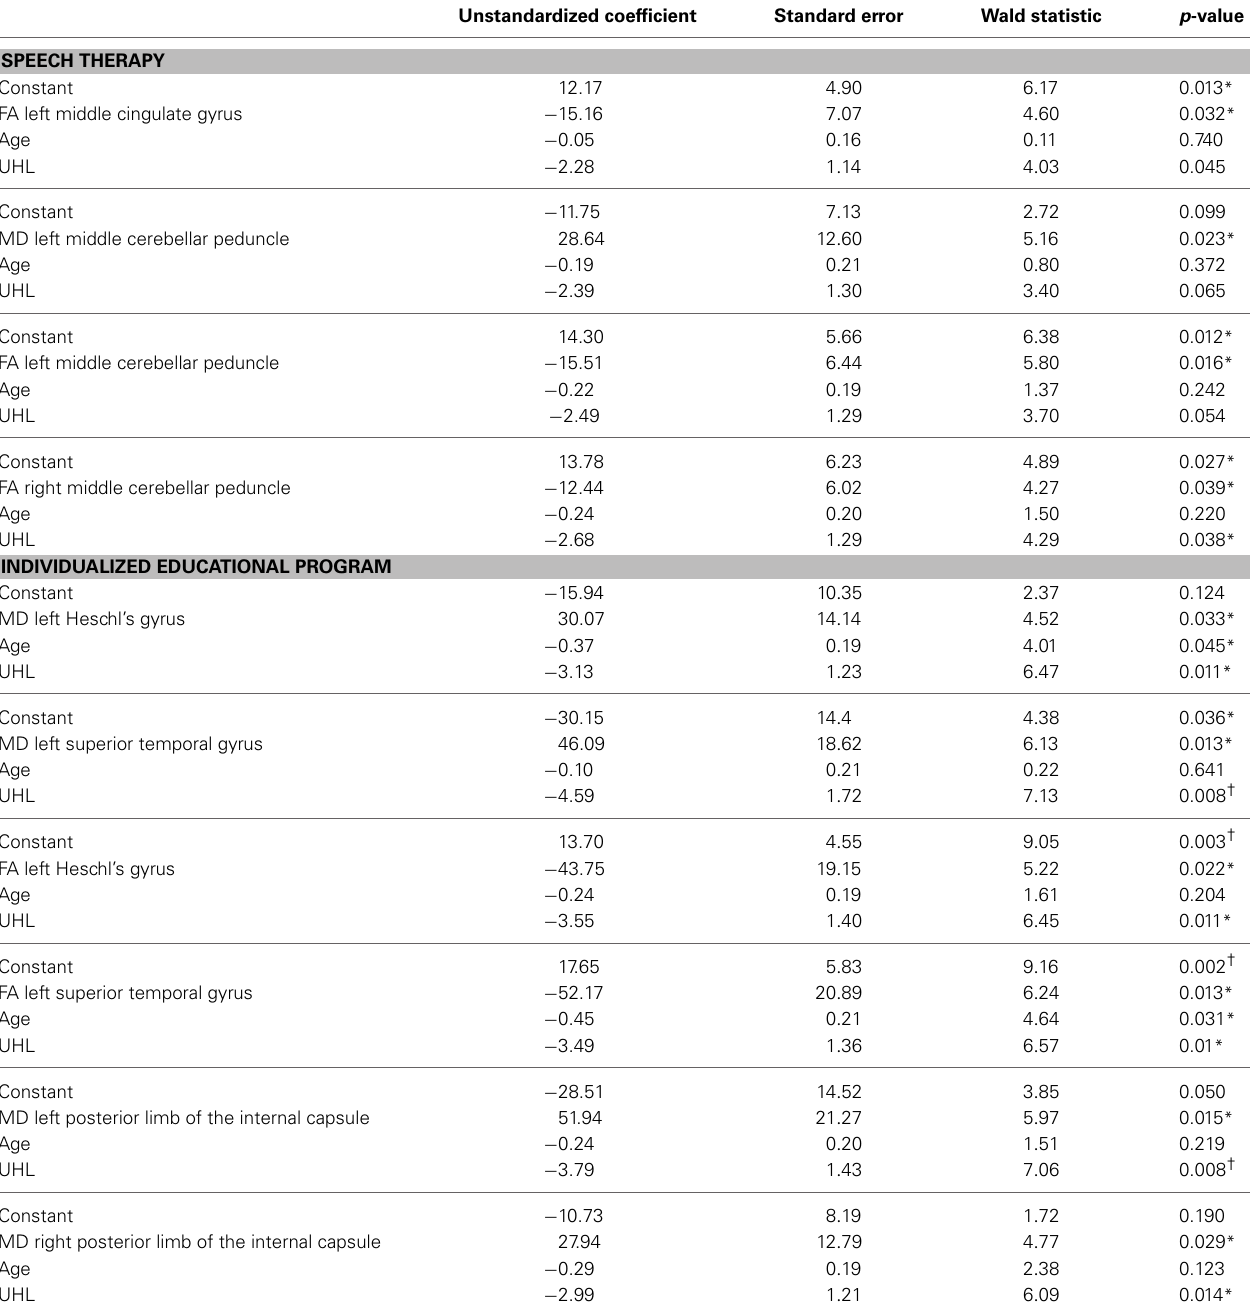
Table 8 | Results of multiple logistic regression analyses for all subjects ( n =